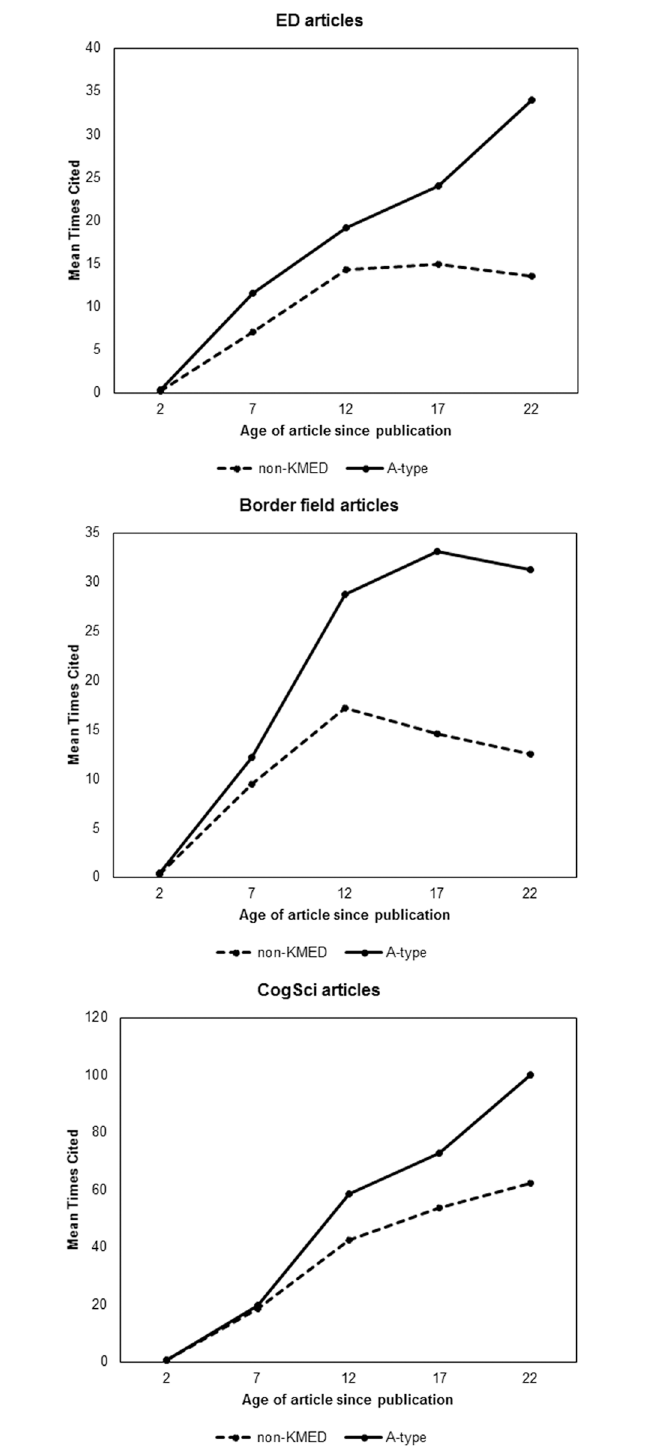
Fig 3. The mean number of citations receivedby articles published in ED, border, and CogSci journals, by age and KMED status.